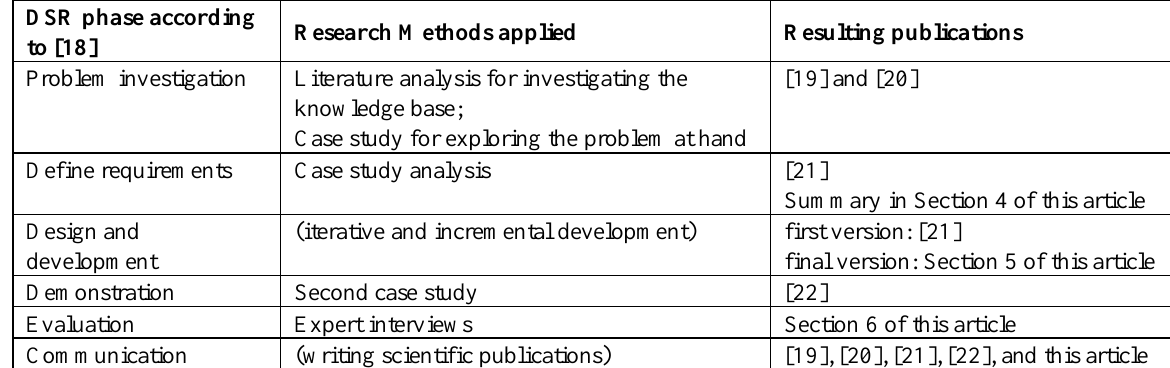
Table 1. DSR phases and their research methods and